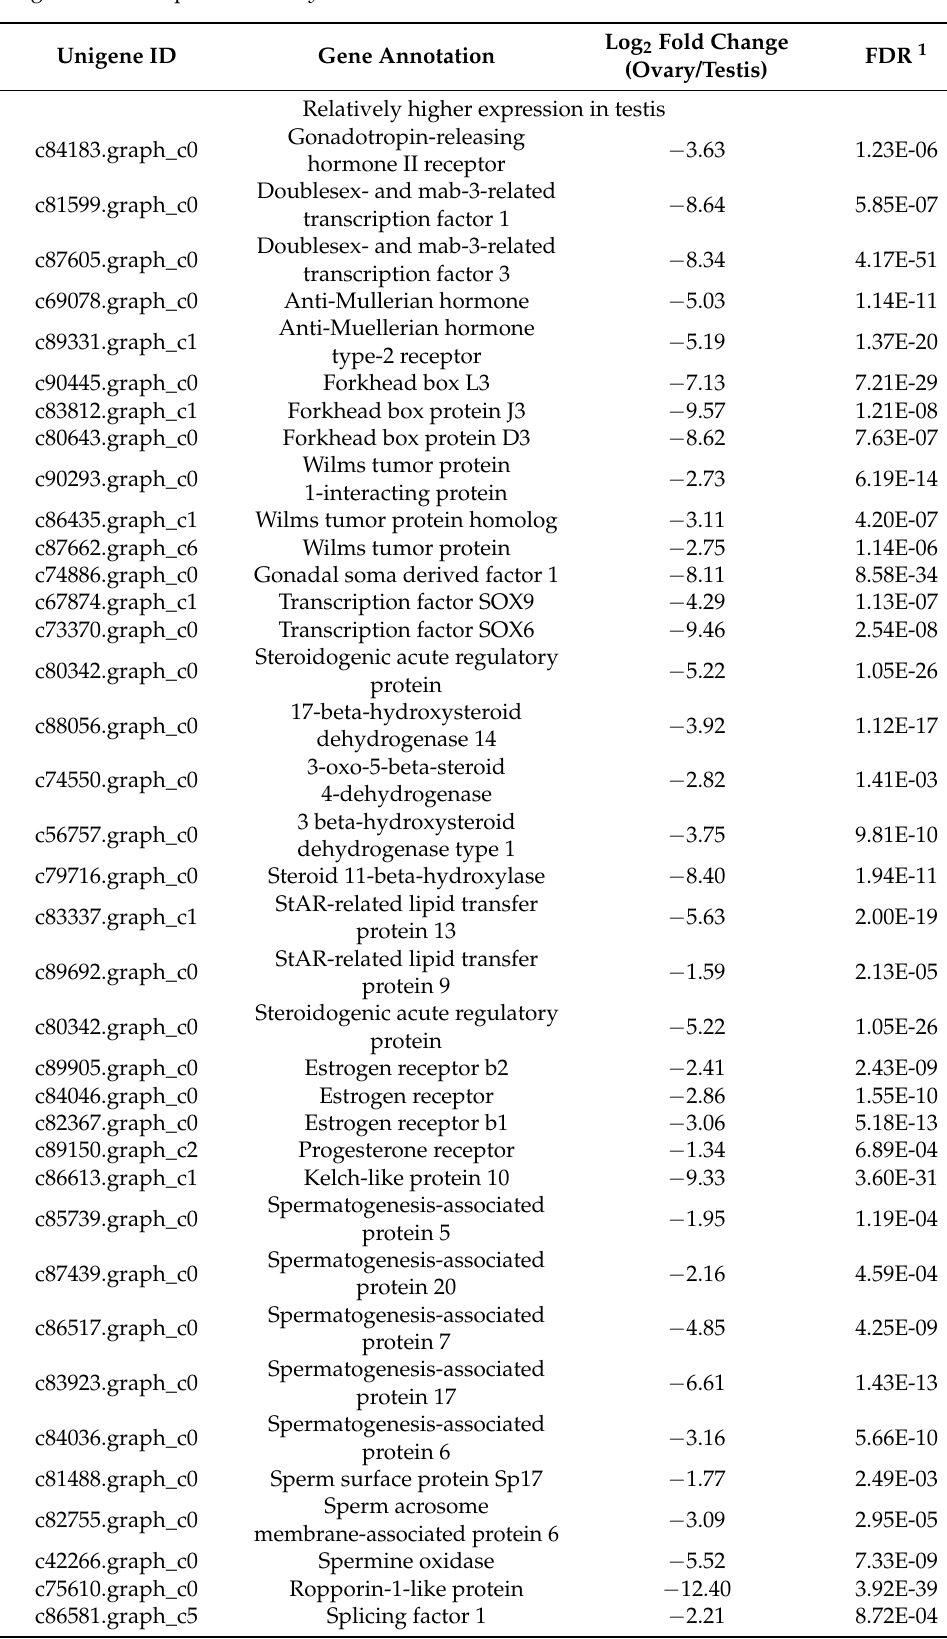
Table 4. Searching for differential expression genes (DEGs) putatively involved in reproduction from the gonad transcriptome of D. hystrix